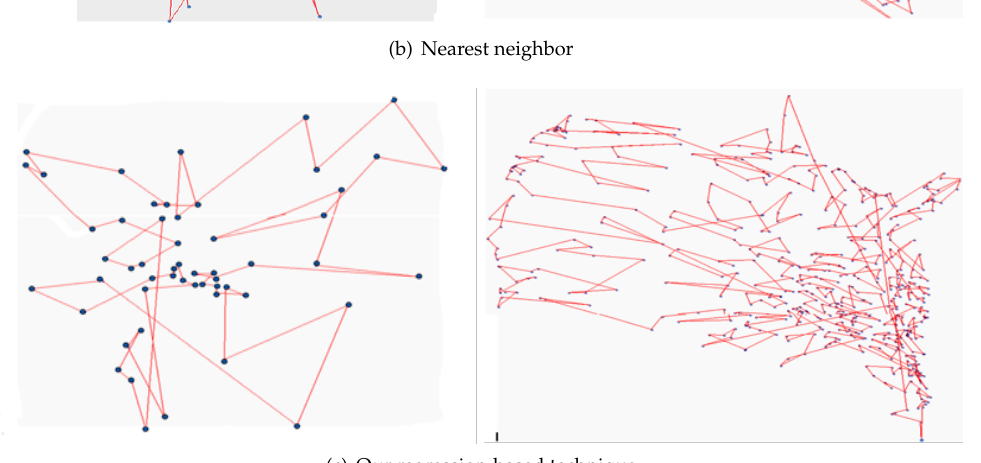
Figure 11. Initial population selection with different techniques on (Left) berlin52, and (Right) att532 using ( a ) Random, ( b ) nearest neighbor, ( c ) our regression-based